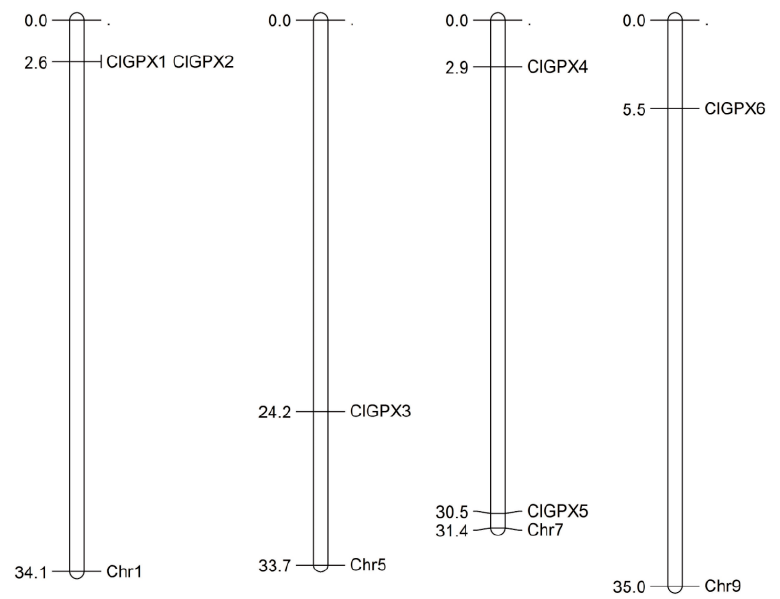
Figure 4. Chromosomal distribution of watermelon GPX genes. The chromosome numbers and its size